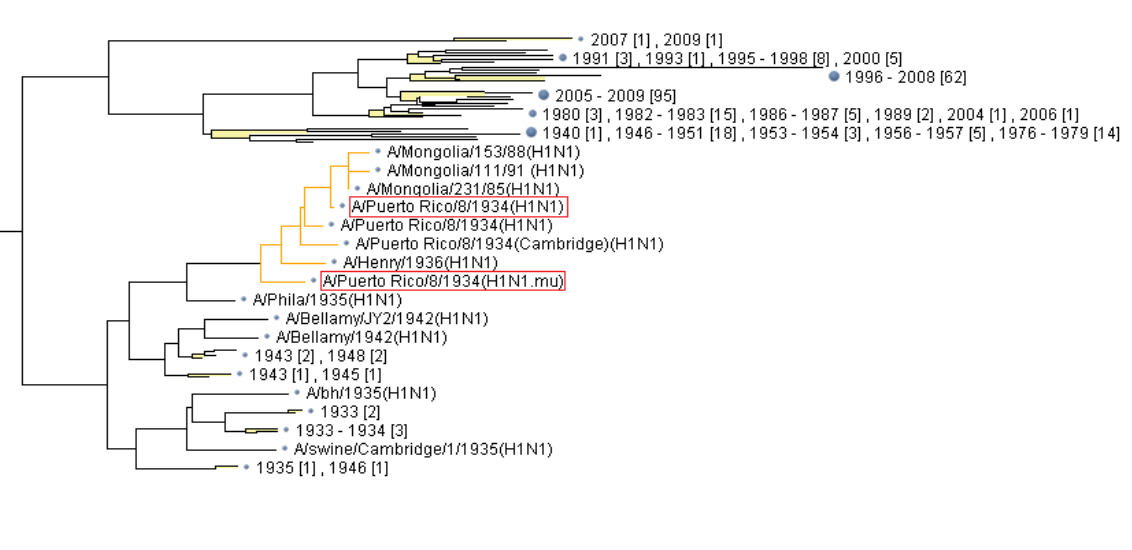
Figure 4. Part of detailed tree picture generated from linkage analysis of mutated nucleocapsid protein identified by MS/MS, by which the neighbor-joining method of clustering was used. The strain containing the mutated nucleocapsid protein (A/Puerto Rico/8/1934 (H1N1.mu)), as well as its original strain (A/Puerto Rico/8/1934 (H1N1)), is labeled with red rectangular